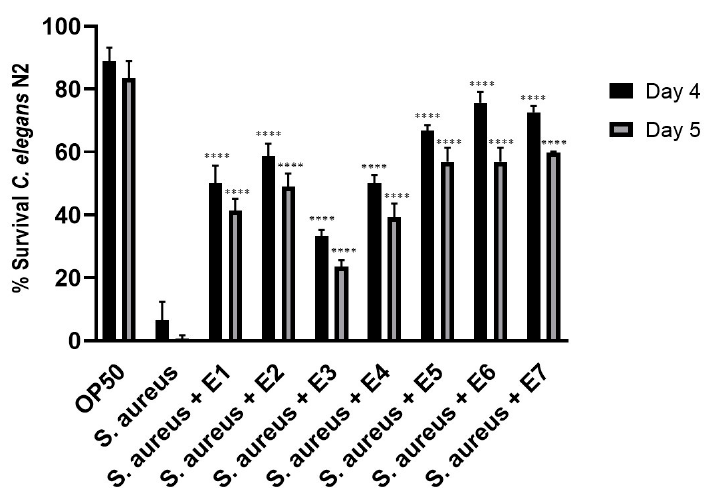
Figure 6. Percentage of survival of Caenorhabditis elegans N2 treated with the different peppermint extracts E1–E7 and infected with the pathogen Staphylococcus aureus (ATCC 25923) at day 4 and 5 post-infection. **** Significant p-value < 0.0001 in comparison to S. aureus condition at every corresponding day post-infection. A two-way ANOVA test was applied. Data are the average of two independent experiments.